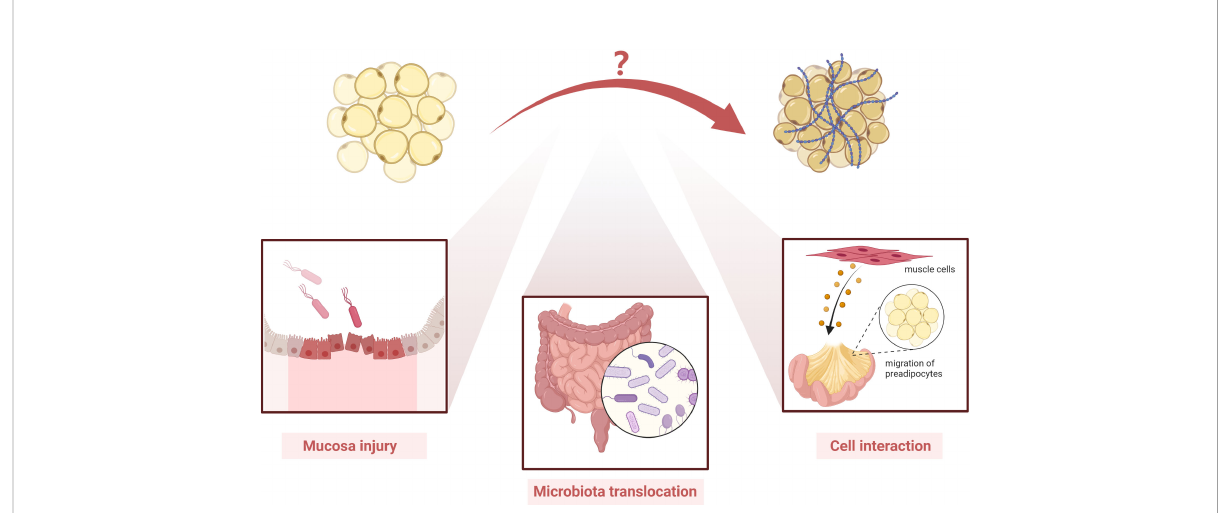
FIGURE 3 Possible players involved in the pathogenesis of creeping fat fi brosis. Although the pathogenesis of creeping fat fi brosis remains unclear, according to the current literature, mucosal injury, microbiota translocation, cell interaction, and activated intestinal muscle cells are important players in creeping fat formation. However, other mechanisms need to be investigated in future